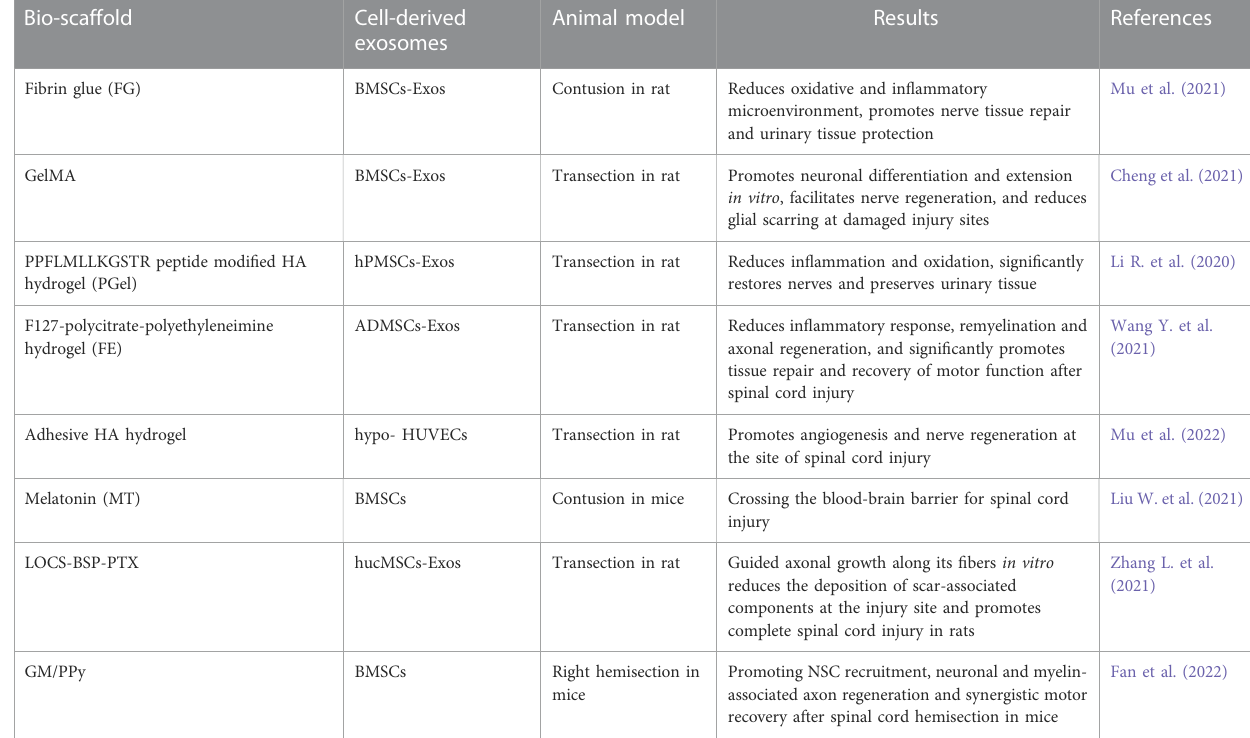
TABLE 2 Study on the treatment of spinal cord injury by cell-derived exosomes combined with biomaterial scaffolds.